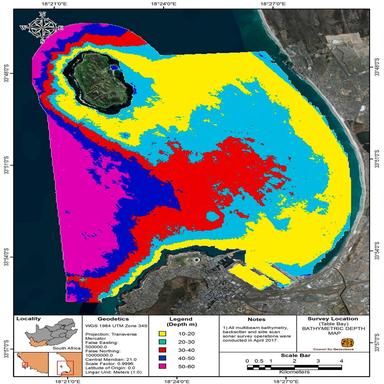
Bathymetric depth bands created using k-means clustering and feature agglomeration methods from multibeam bathymetry data in Table Bay.